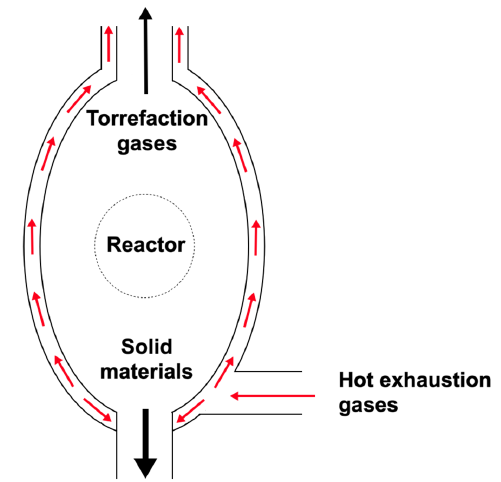
Figure 18. Layout of the double-walled discharge chamber to ensure heating and prevent condensation of the torrefaction gases.